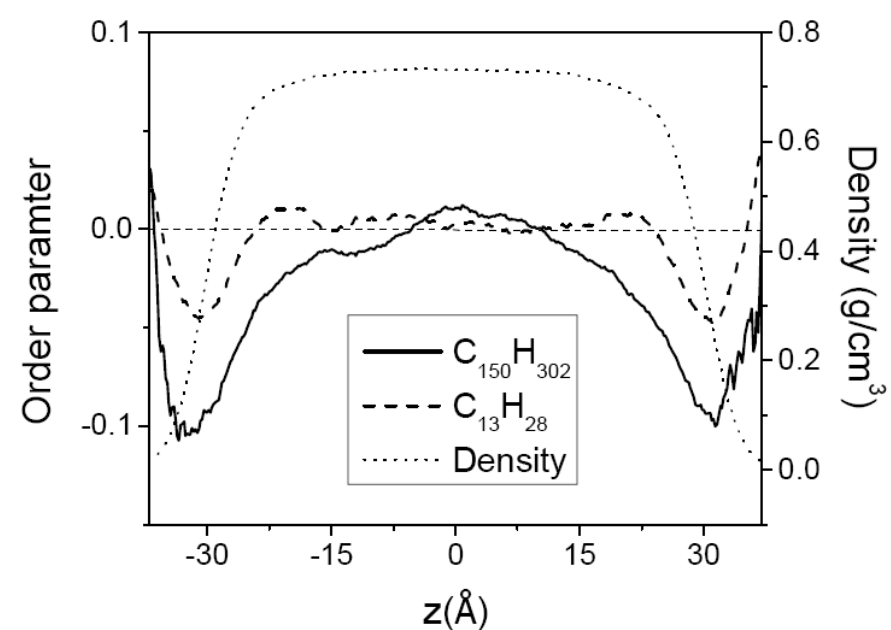
Figure 10. The order parameters of each component of (C 150 H 302 + C 13 H 28 ) mixture melt film at 400 K along the film thickness direction ( z ) with the film center at z = 0, plotted together with the overall density profile.